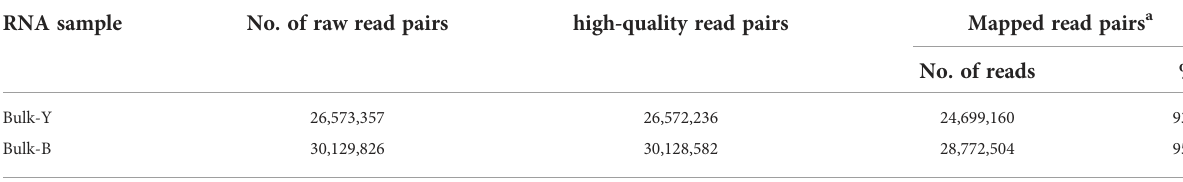
TABLE 1 Statistical parameters of the BSR-Seq analysis for the yellow hulled lines (Bulk-Y) and brown-hulled lines (Bulk-B). RNA